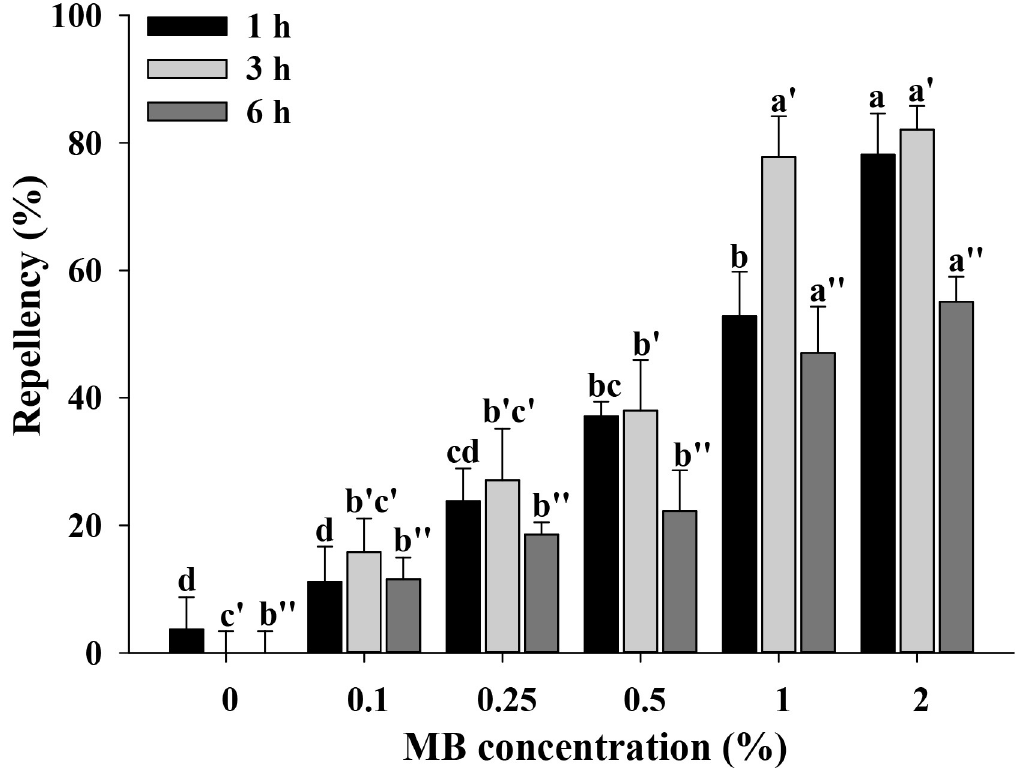
Fig 5. Repellency effects of methyl benzoate against adults of Bemisia tabaci . A binary-choice bioassay tube was used to determine behavioral responses of B . tabaci after encountering 0% (control), 0.1%, 0.25%, 0.5%, 1%, and 2% MB solutions. Repellency was determined at 1, 3, and 6 h post-treatment. Values are the means of three replications. Means followed by different superscript letters are significantly different at α = 0.05 ( N = 3, df = 5, 17; for 1 h, F = 26.11; P < 0.0001; for 3 h, F = 29.99; P < 0.0001; for 6 h, F = 19.87; P < 0.0001).